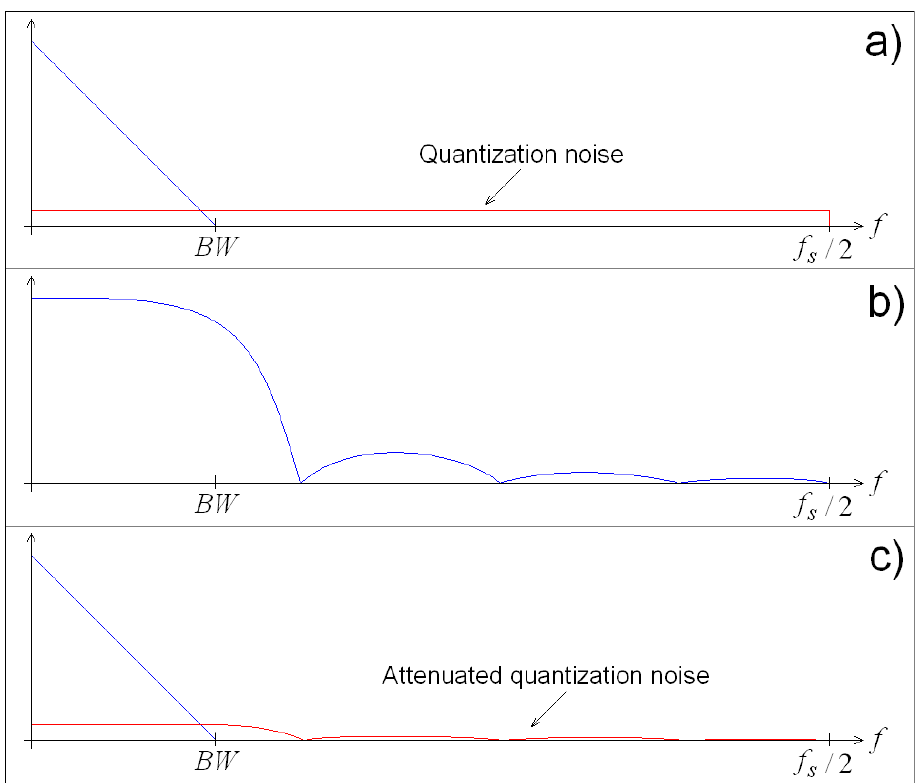
Figure 4. SQNR improvement with LPF. (a) Original oversampled signal. (b) Transfer characteristic of a real LPF. (c) Filtered